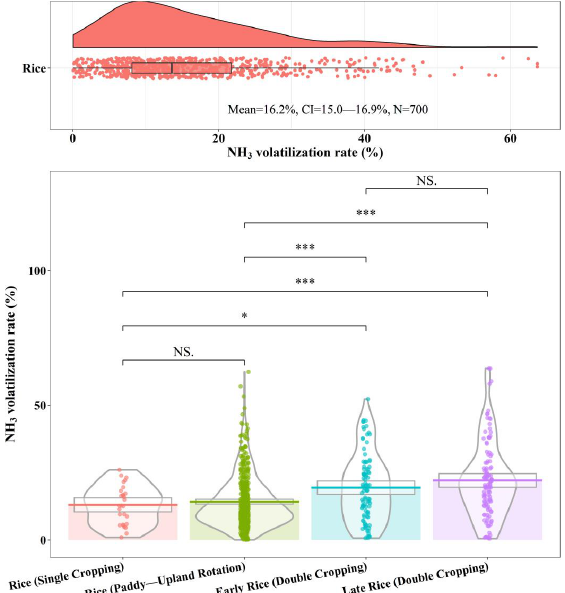
Figure 1. NH 3 loss from different rice production systems in China: ( A ) general mean AVR in rice fields from across China: CI is the confidence interval generated by bootstrapping; N is the number of observations; ( B ) mean AVR of different rice-based production systems: an asterisk (*) between two columns implies a significant difference, with * and *** indicating significance levels at 0.05 and 0.001, respectively. NS between two columns implies a non-significant difference.